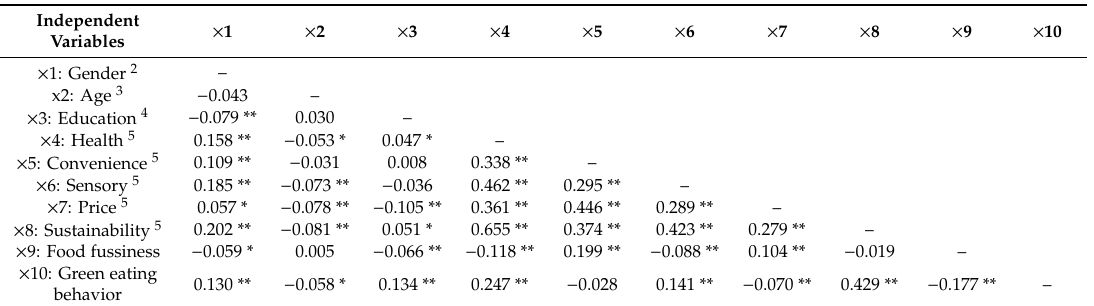
Table A1. Correlation matrix of determinants in ordinal regression analyses for acceptance to consume sustainable protein sources in older adults in five EU countries 1